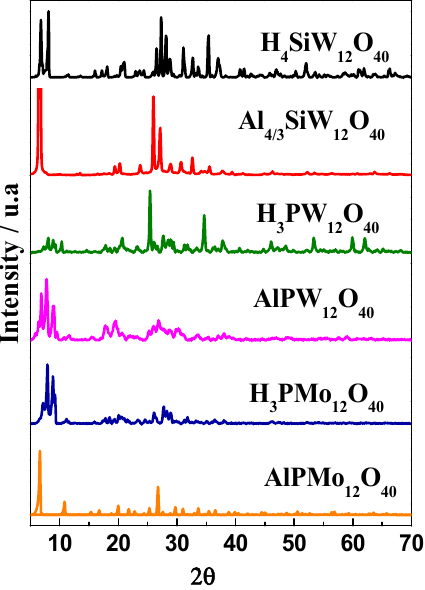
8 of 24 Table 1. Hydration water molecules were determined through thermal analysis (DTG) [27]. Catalyst